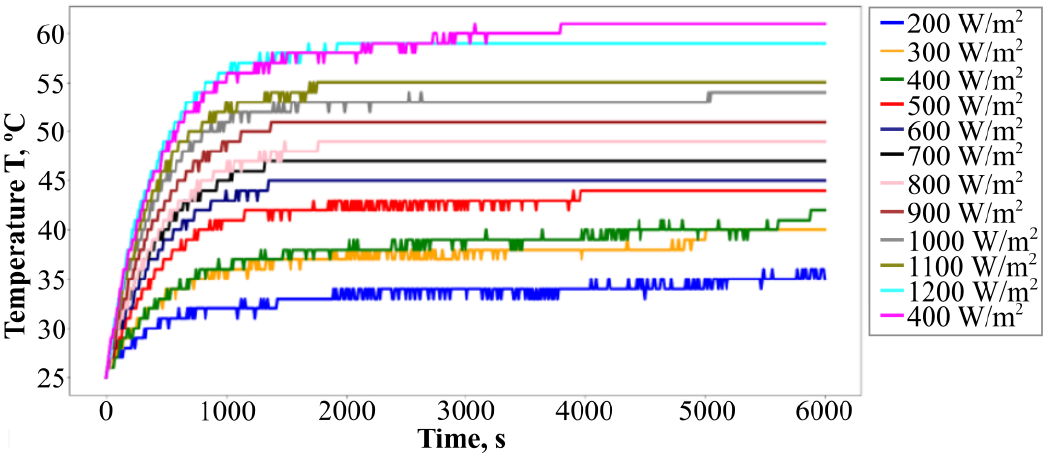
Figure 12. Heating of a solar cell at different incident radiation powers.